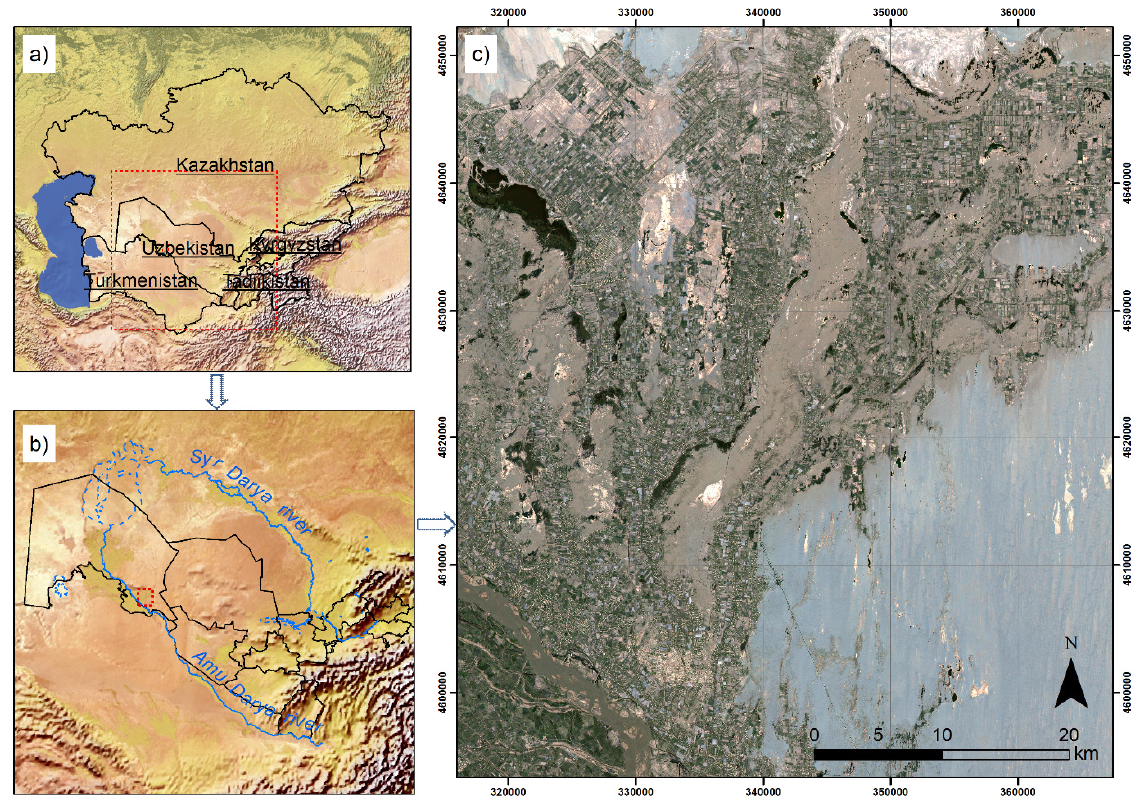
Figure 1. Location of the study area, ( a ) in Central Asia, ( b ) in Uzbekistan and ( c ) study area in the south-eastern part of Autonomous Republic of Karakalpakstan. The SPOT image (acquired 13 August 2010) provides background image in